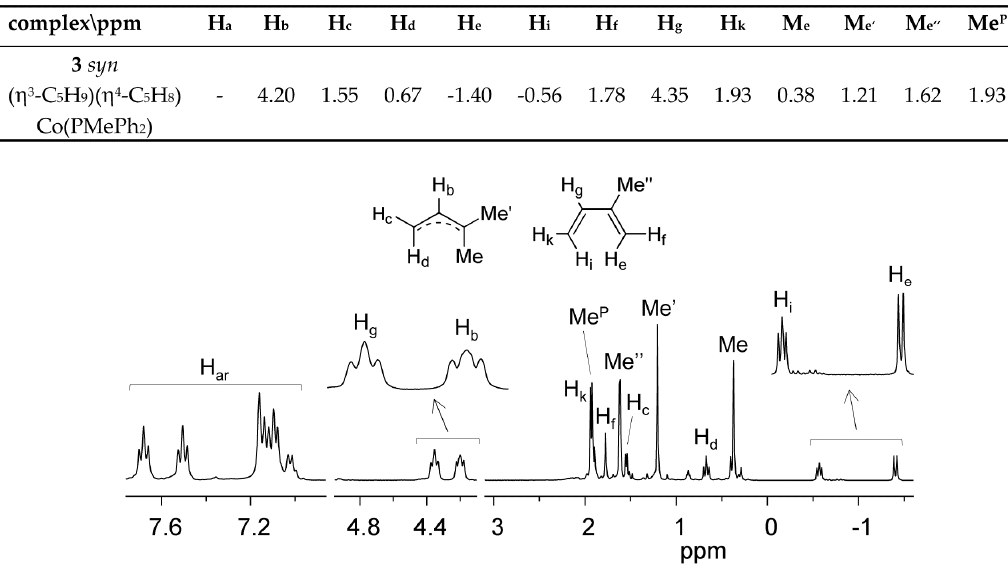
Figure 4. 1 H NMR spectra of ( η 3 -C 5 H 9 )( η 4 -C 5 H 8 )Co(PMePh 2 ) ( 3 ) (Me P indicates the protons of the methyl on the ligand phosphorus atom, H ar = aryl protons).